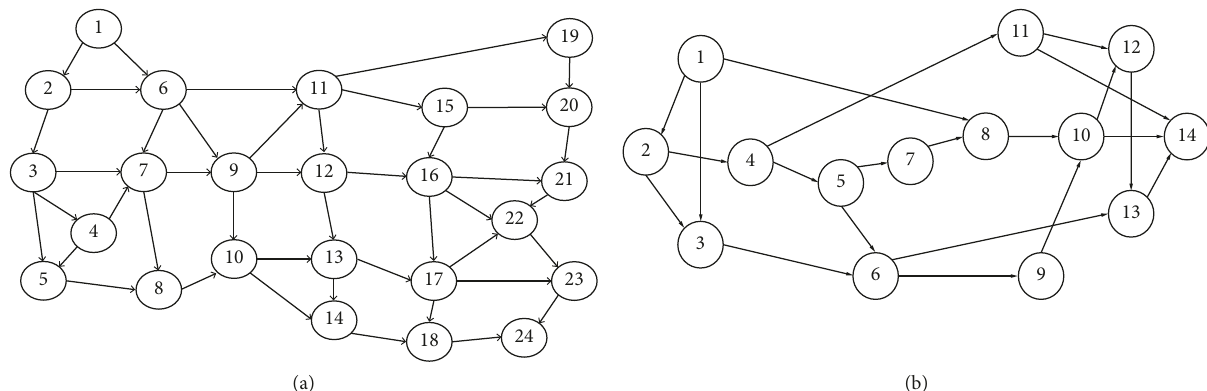
Figure 1: (a) 24-node US-directed mesh network with s � 1 and t � 24. (b) 14-node NSF-directed mesh network with s � 1 and t �